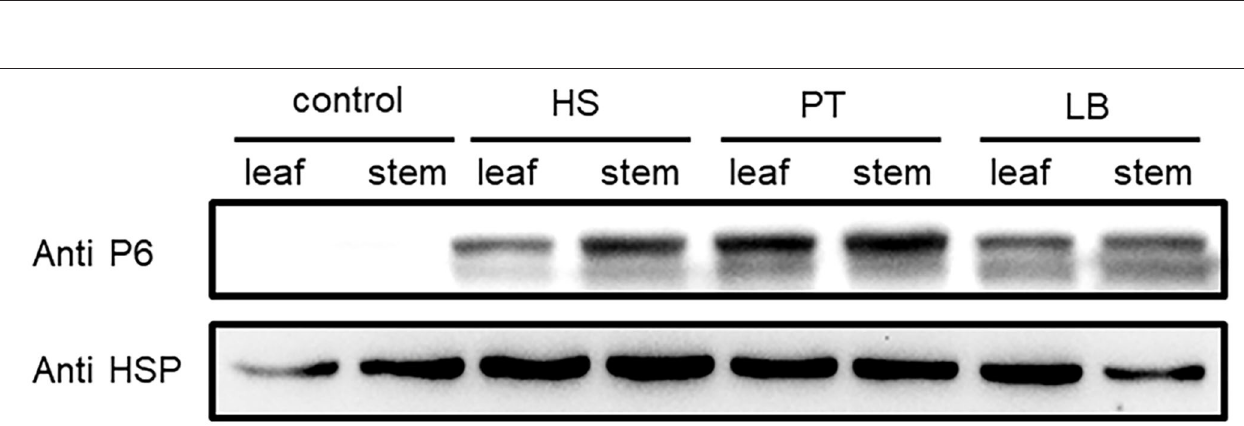
Frontiers in Sustainable Food Systems |